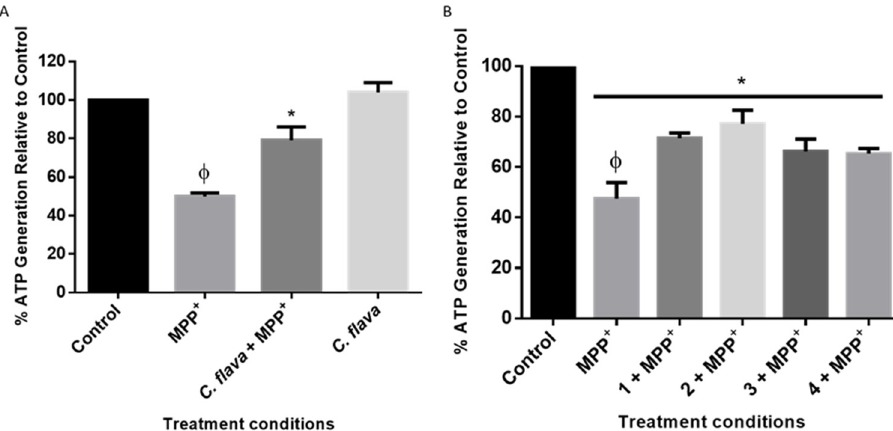
Figure 6. Crossyne flava and compounds attenuated MPP + -induced ATP degeneration. Cells were pre-treated with 2.5 µ g/mL of C. flava ( A ) and compounds ( B ) before exposure to 2000 µ M of MPP + for 24 h and ATP levels assessed. Each bar represents the mean percentage level relative to the control, and the significance of the difference is indicated with * when extract/compounds are compared to MPP + and φ (MPP + vs. control).